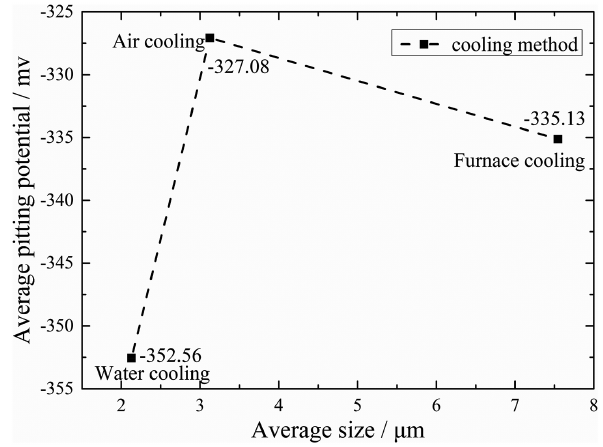
Figure 3: Relationship curve of the average size and the average pitting potential.